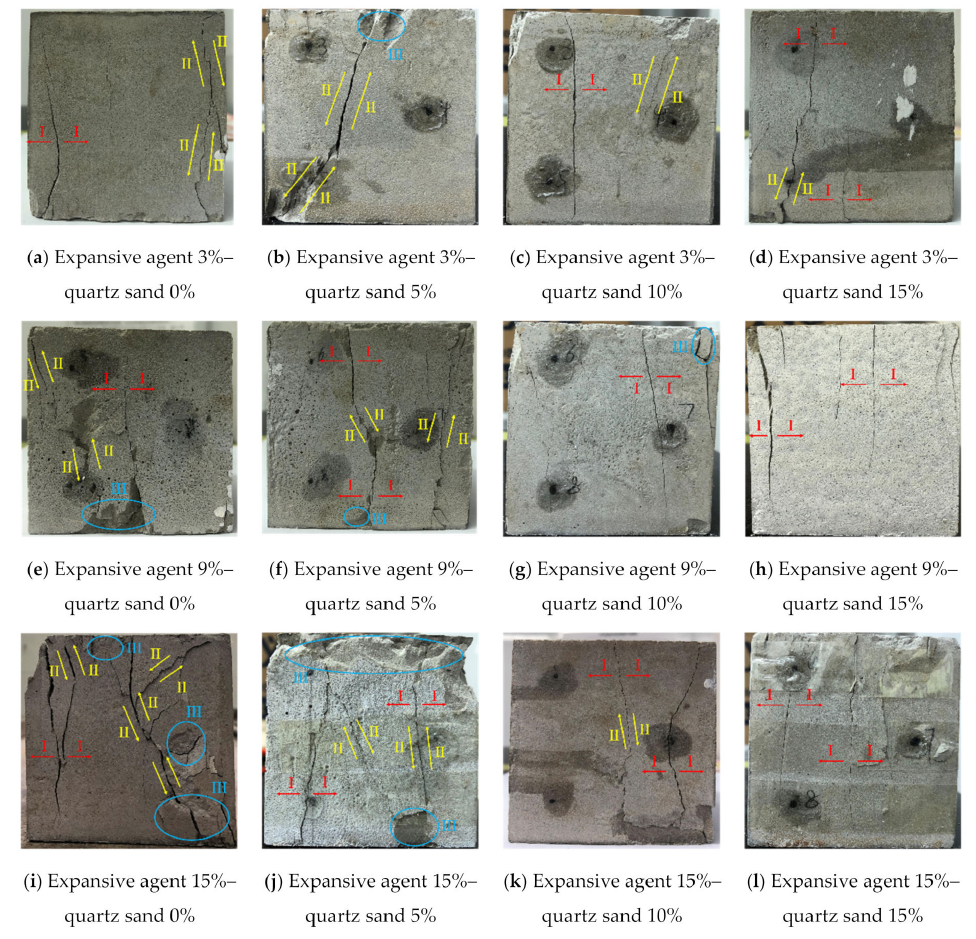
Figure 8. Failure modes of expansive grout samples under uniaxial